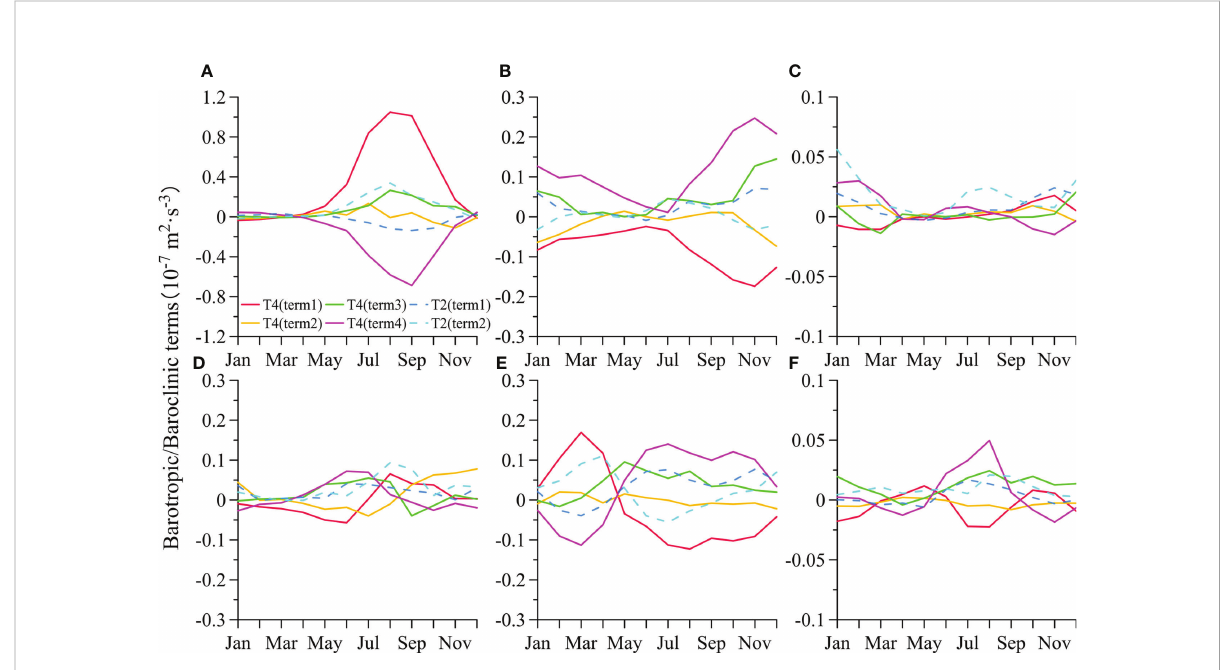
FIGURE 6 Monthly variation of the four terms in T4 and the two terms in T2 averaged in the A1 (A) , A2 (B) , A3 (C) , B1 (D) , B2 (E) , and B3 (F)